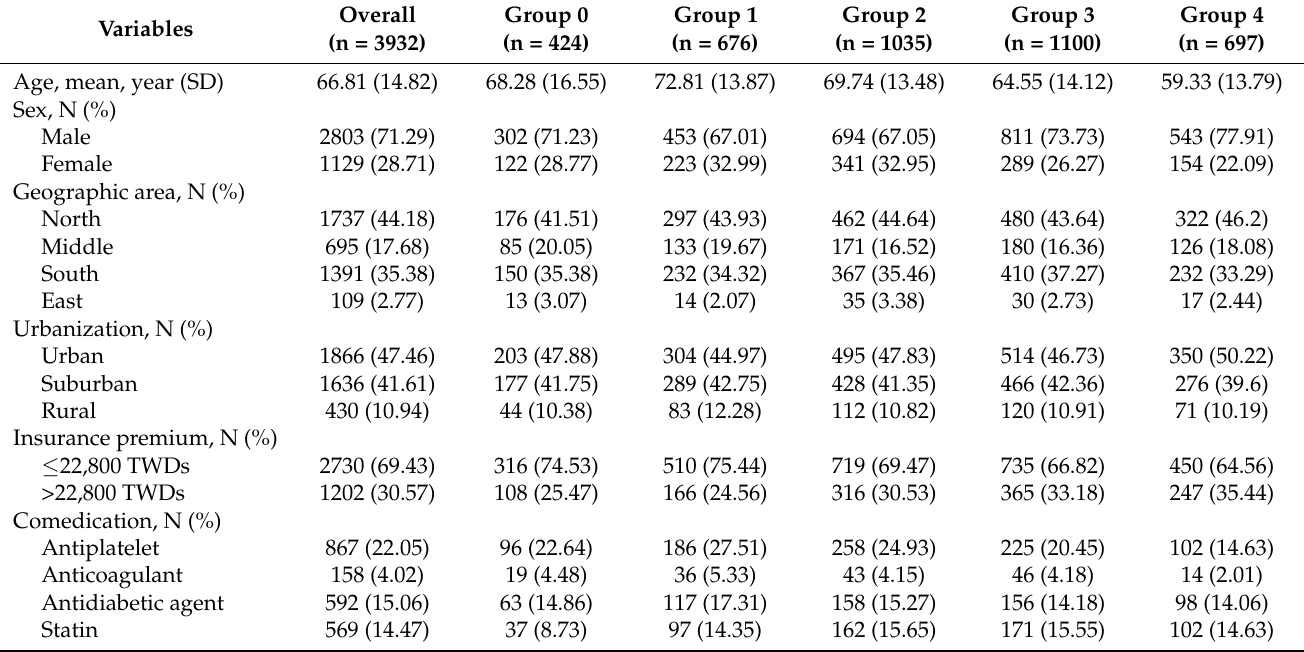
Figure 1. Flow chat of study population. Table 1. Characteristics of Non-operated AD Patients, Stratified by Group.